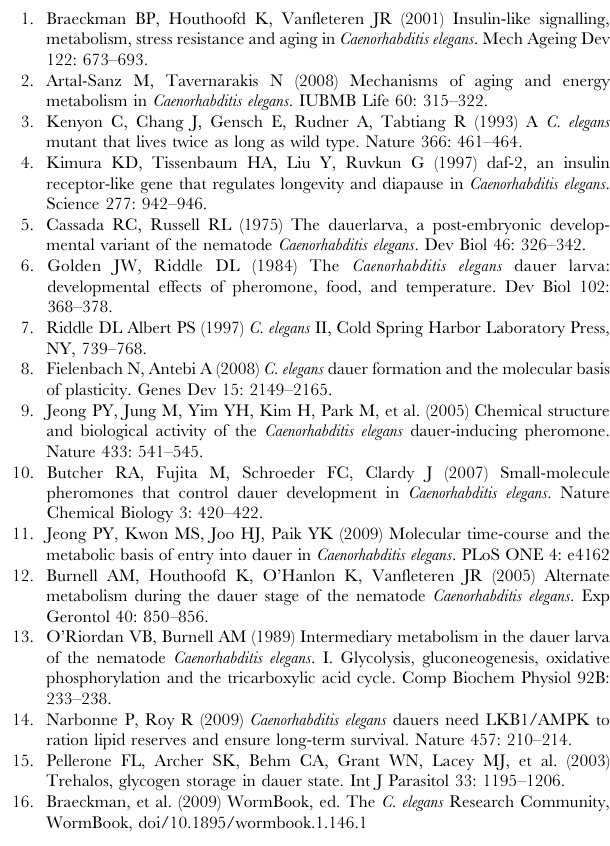
kinase. Figure S2 Lifespan and fat content of pdhk-2 mutants under well-fed conditions. ( A ) Lifespan analysis of N2, pdhk-